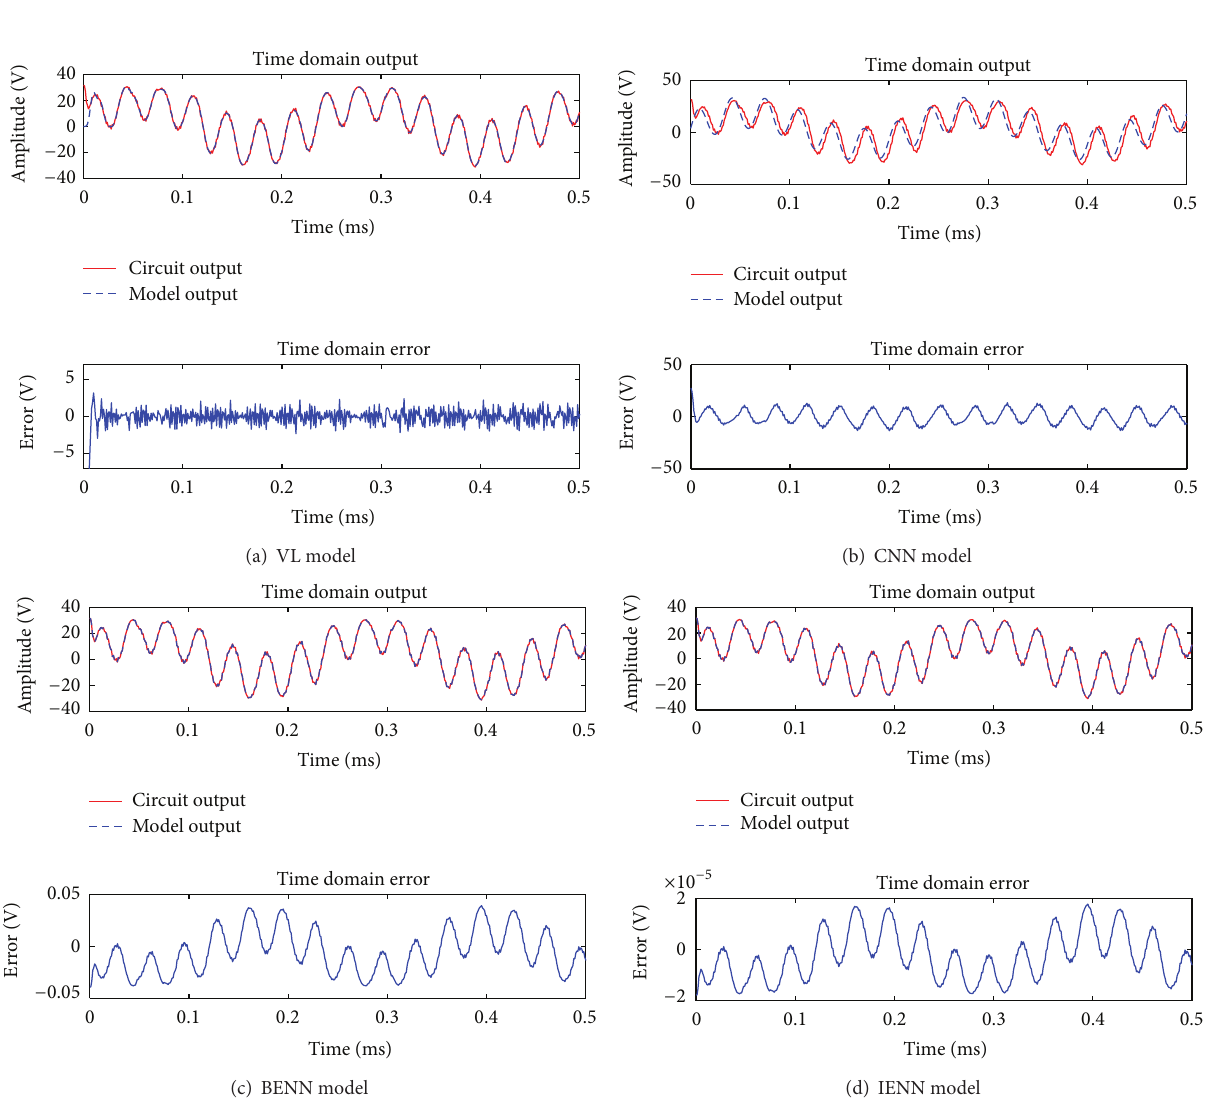
Figure 5: Comparison among four behavioral models in time domain with two-tone signal input. Table 1: Mean error 𝜎 and maximum transient error 𝜎 max of four behavioral models with two-tone signal input.